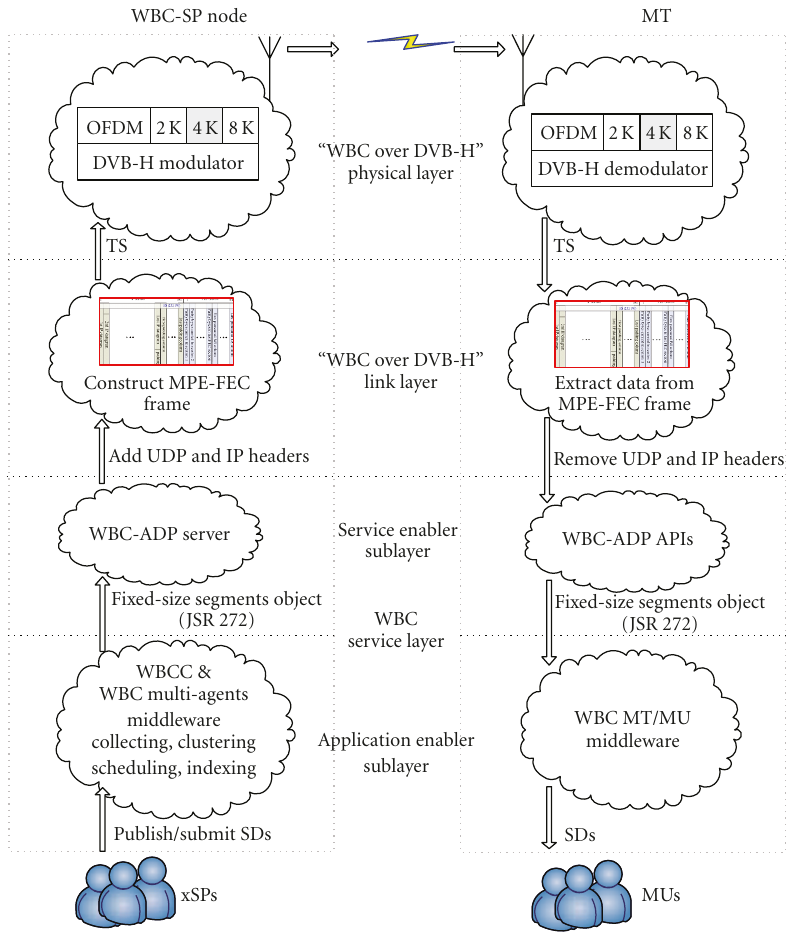
Figure 1: The “WBC over DVB-H” layered